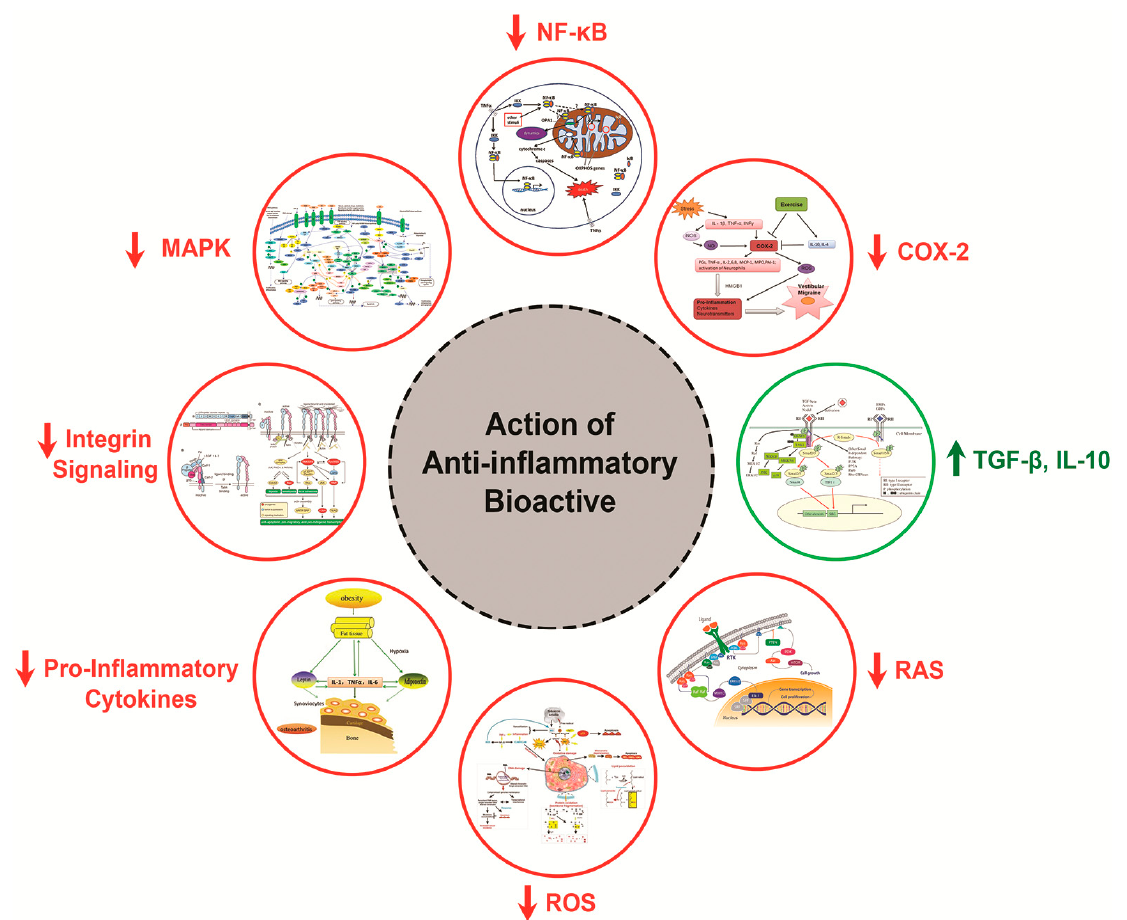
Figure 5. The schematic diagram indicates the anti-inflammatory activity of bioactive peptides derived from food protein occurs via inhibition of the NF-KB, MAPK, and JAK-STAT pathways. MAPK: mitogen-activated protein kinase; MAP3K: MAPK kinase; NF- κ B: nuclear factor-kappa B; TGF- β : transforming growth factor β ; TNF- α : tumor necrosis factor α ; JAK-STAT: Janus kinase-signal transducer and activator of transcription. Table 3. Antidiabetic peptides for type 2 diabetes mellitus (T2DM). Antidiabetic Pep- Hypoglycaemia tides